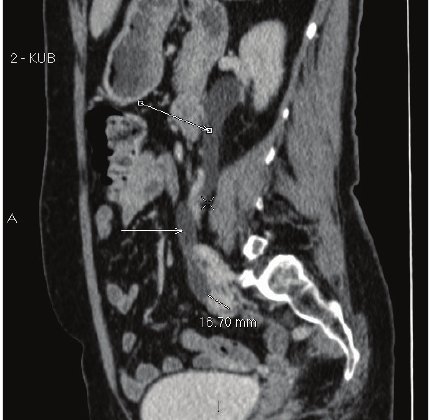
Figure 5: Portal venous phase (split bolus) CT urogram at time of staging. This shows an obstructing, synchronous, enhancing 16mm soft tissue lesion in the lower third of the right ureter. Arrows demonstrate hydroureter above